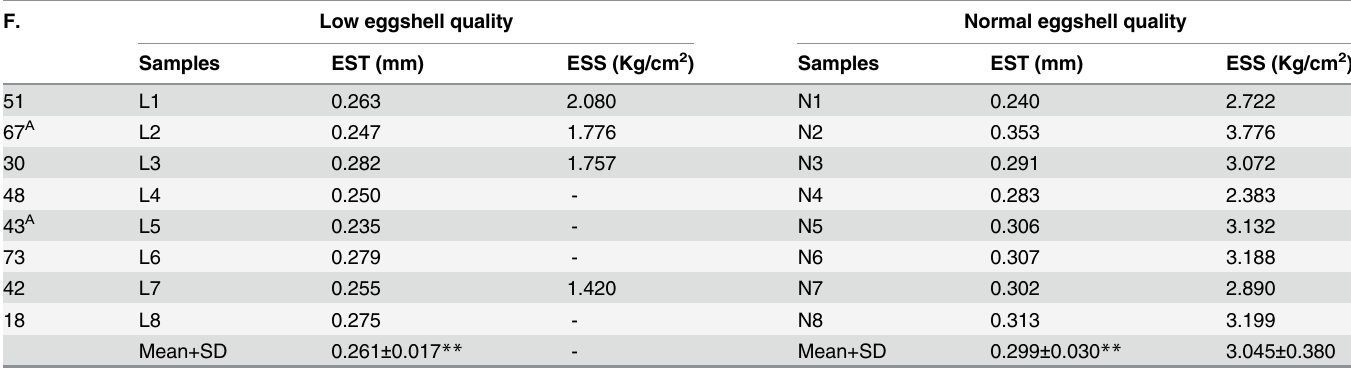
Uterus tissues were collected from the hens at 18 h after previous oviposition and were snap-frozen in liquid nitrogen and stored at − 80°C prior to total RNA extraction. Two Table 1. Eggshell quality in Rhode Island White hens.